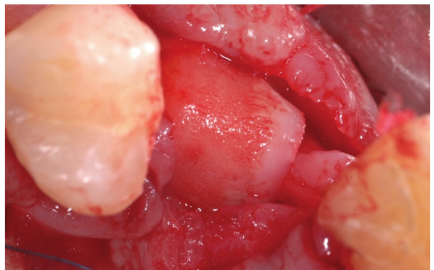
Figure 14: A free deepithelized gingival graft was used to enhance the amount of peri-implant soft